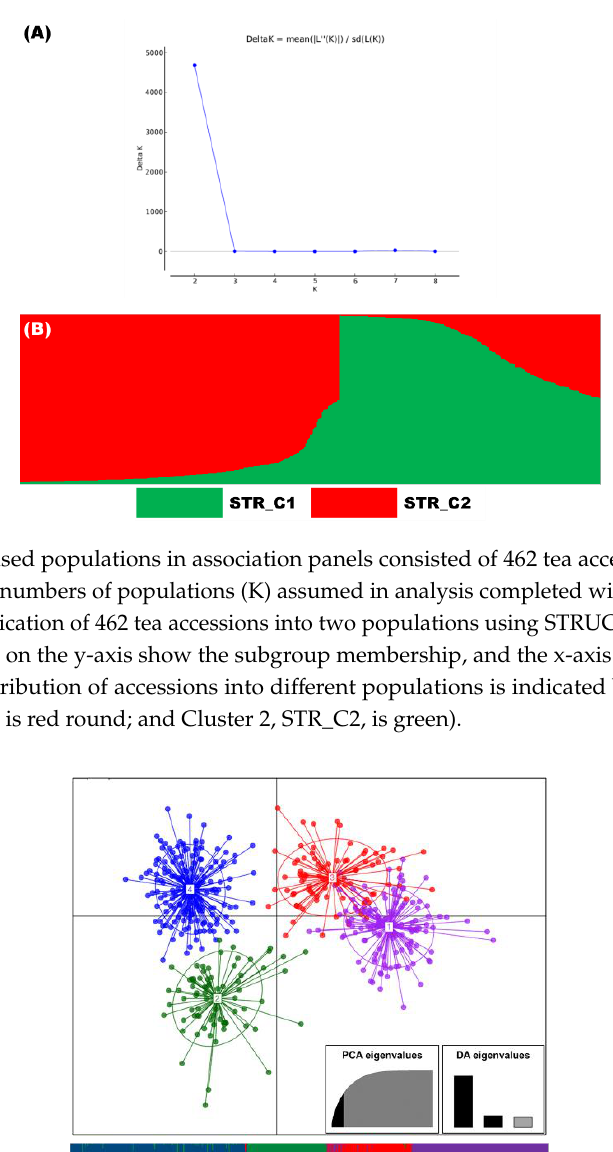
- 1 df, degree of freedom; SS, sum of squares; MS, mean squares; Est. Var., estimates of variance; %, percent of variance.